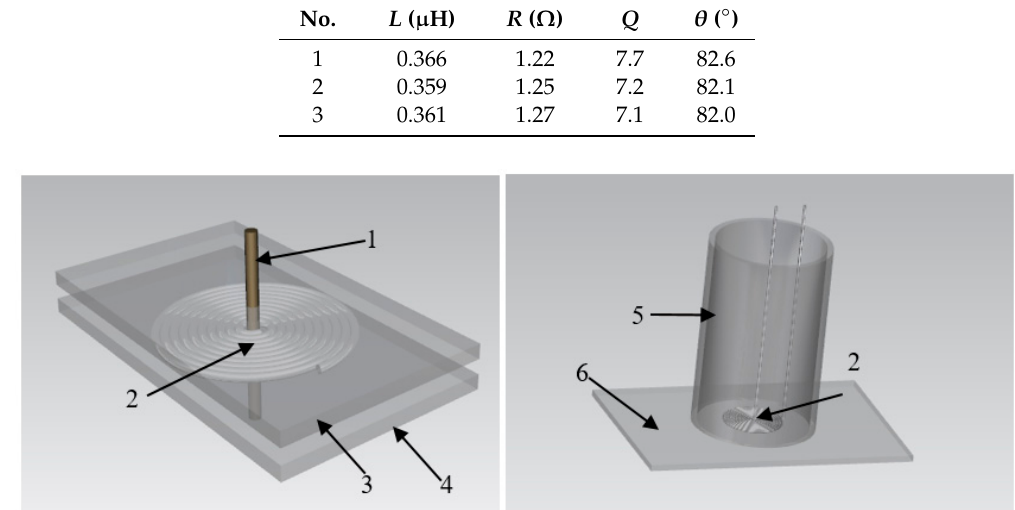
Figure 5. Sensor making device, wherein 1 is central tube, 2 is planar coil, 3 is upper plate, 4 is bottom plate, 5 is ceramic gelcontainer, 6 is fixed plate.